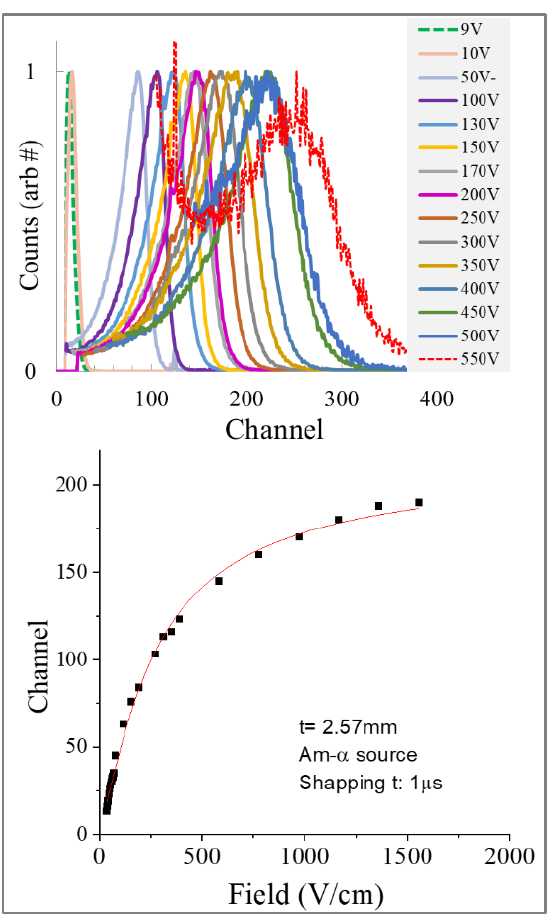
Figure 16. Spectral response at increasing applied bias, and Hecht equation fitting for µτ h measure- ments (5.6 × 10 −4 cm 2 /V) by using 241 Am α source for CRY-4.